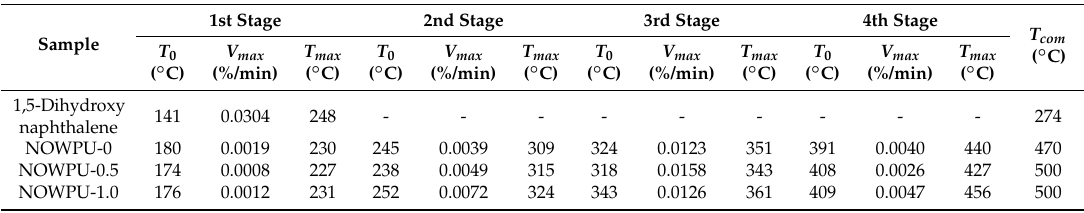
Table 3. Maximum initial decomposition temperature ( T 0 ), maximum temperature ( T max ), and maximum decomposition speed ( V max ) of NOWPU